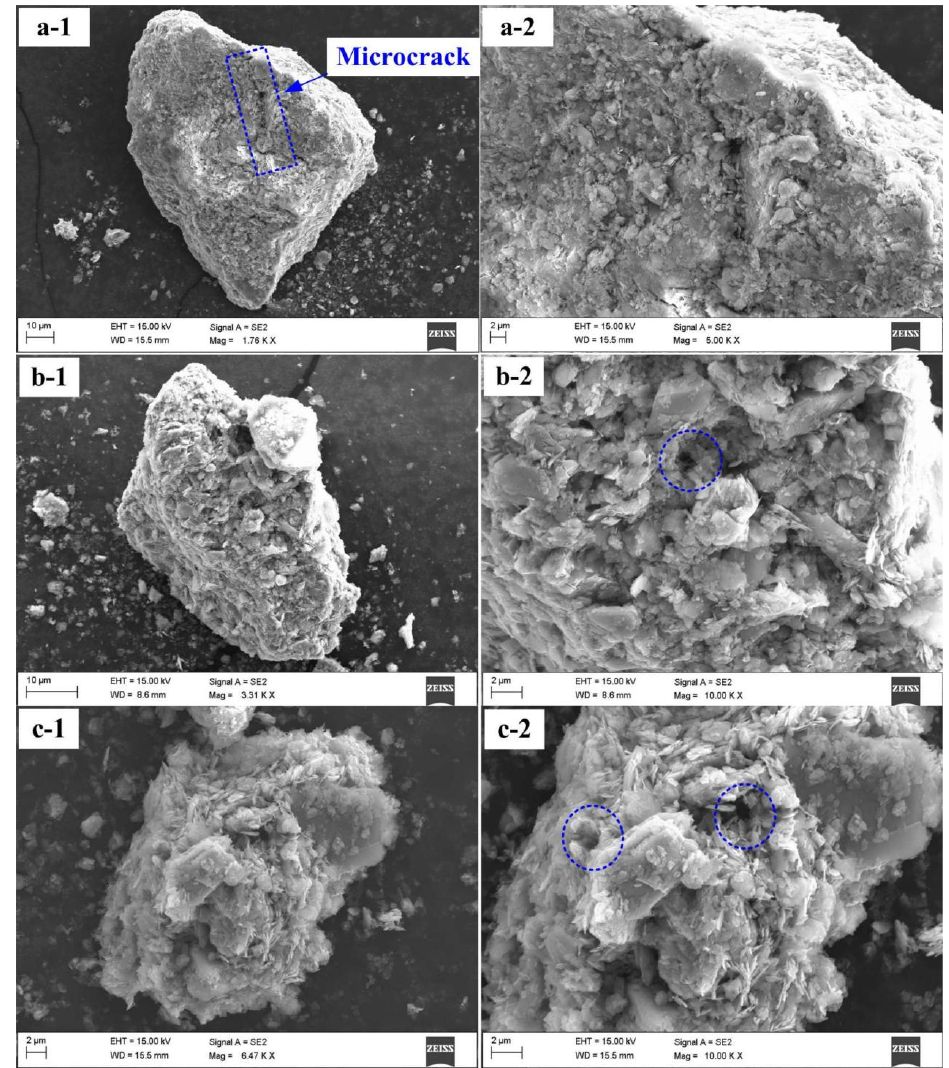
Figure 12. SEM images of materials with different CO contents, with roasting temperature of 650 °C for 5 min: ( a-1 , a-2 ) 15%, ( b-1 , b-2 ) 5%, ( c-1 , c-2 ) 35%. for 5 min: ( a-1 , a-2 ) 15%, ( b-1 , b-2 ) 5%, ( c-1 , c-2 )